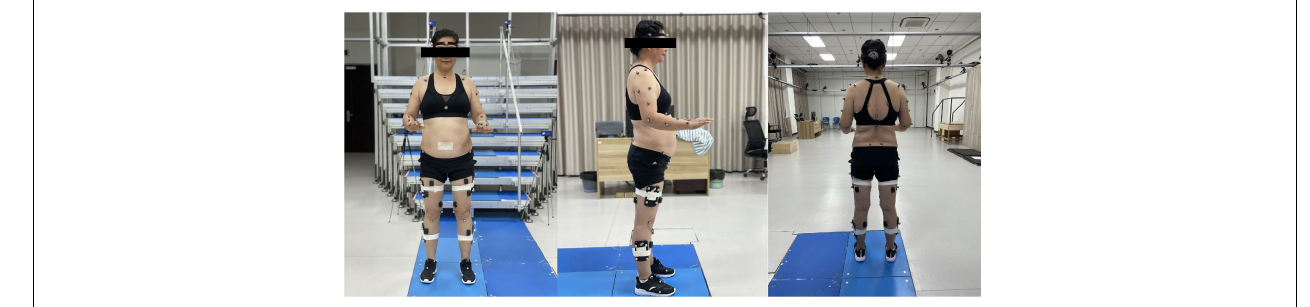
FIGURE 2 | The placement of the markers.